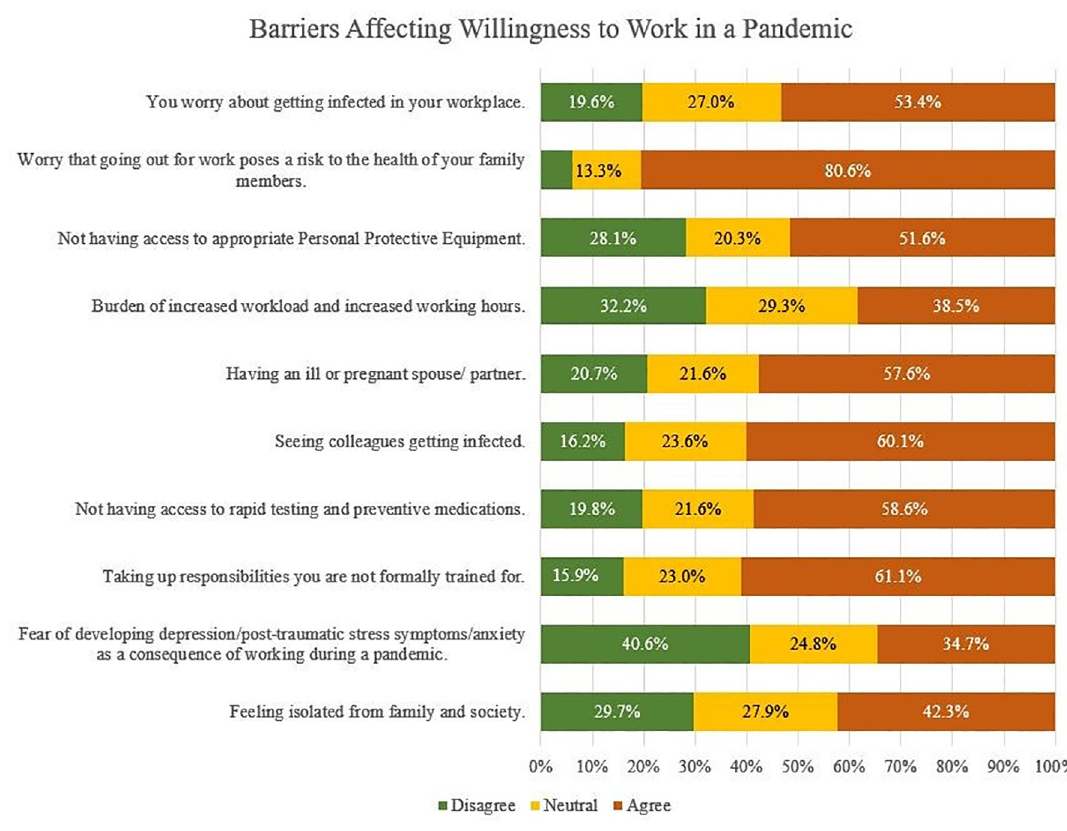
Fig 4. Barriers affecting willingness to work in a